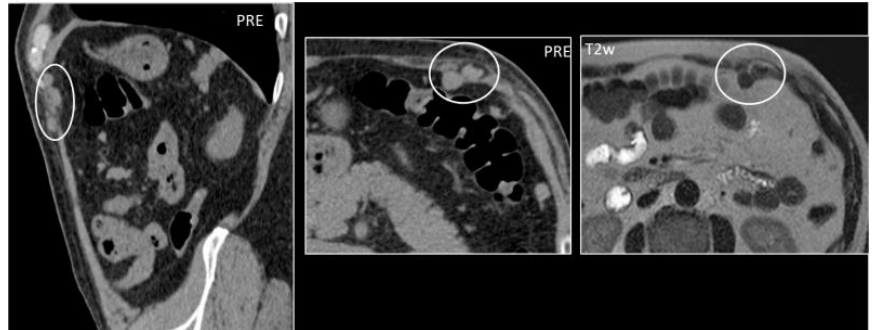
Figure 16. A 59-year-old woman who underwent splenectomy some years prior. During a CT scan, new, rounded masses (circles) were found along the peritoneum and the left rectus abdominis muscle. These formations show parenchymal attenuation on CT (pictures 1 and 2) and share the same T2 intensity as the spleen. These lesions were later characterized as splenosis.